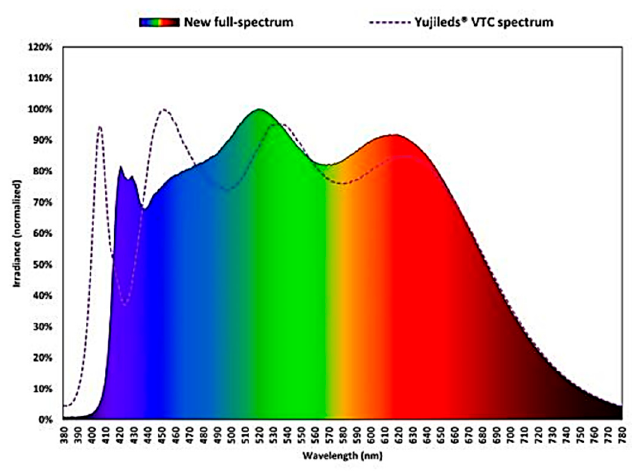
Figure 5. YUJILEDS ® VTC series full spectrum vs. new full spectrum light-emitting diodes